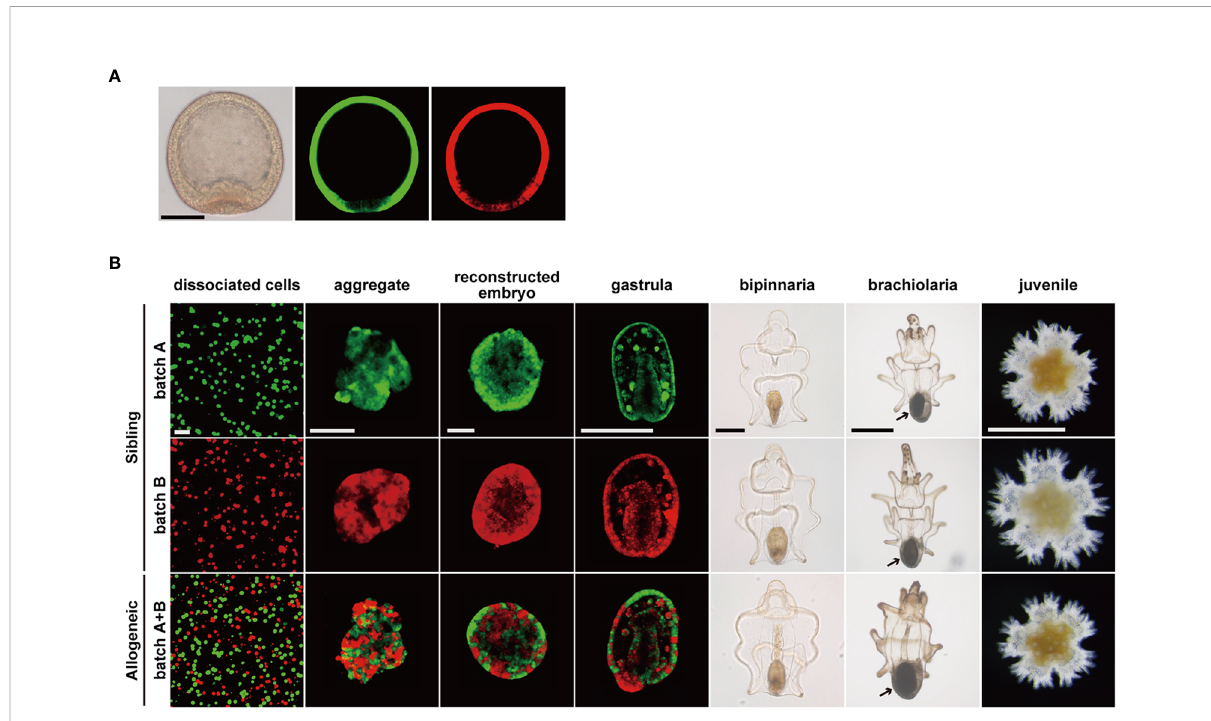
FIGURE 4 Developmental process of chimeric larvae. (A) Fluorescent labeled blastulae before dissociation. Images of differential interference contrast (left), stained by CMFDA (middle), stained by CFDA (right). Scale bar: 100 µm. (B) Developmental processes of reconstructed chimeras. Arrows: adult rudiment. Scale bars: 40 µm (dissociated cells to reconstructed embryo), 200 µm (gastrula and bipinnaria), 500 µm (brachiolaria and